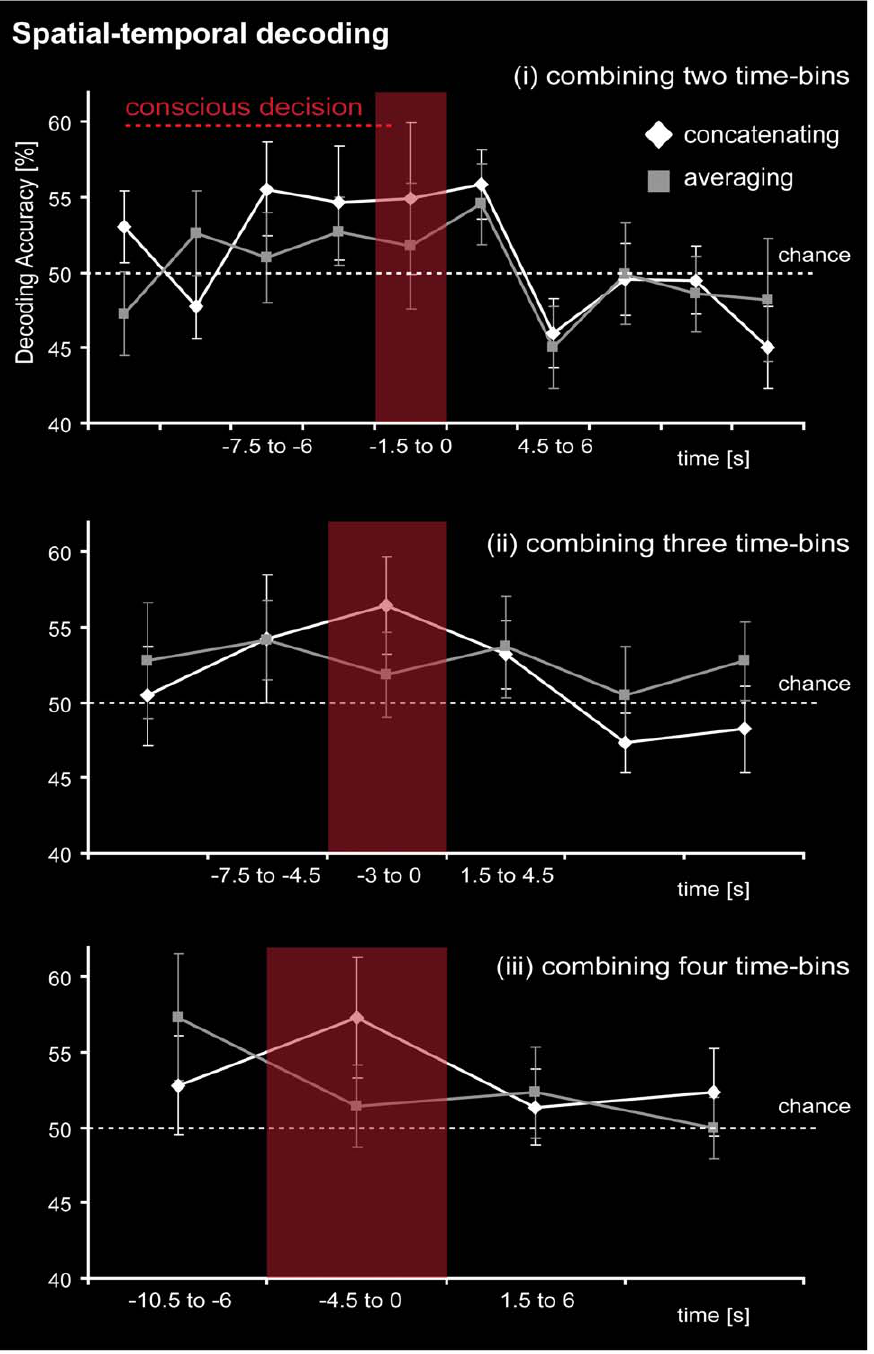
Figure 6. Temporal pattern stability. Temporal-spatial decoding analysis. The spatial activation patterns from the searchlight cluster, which was found to give best results in decoding accuracy (MNI 2 23 59 2 9), was extracted in the individual subjects’ data. The original patterns from the time- bins (1 time-bin=1.5 s) were combined by concatenating (white) and averaging (grey) the respective pattern vectors in steps of either (i) two time- bins, (ii) three time-bins, or (iii) four time-bins. The reference time-bin for vector concatenation was the time point of the decision (time 0 s). The resulting pattern vectors additionally represented temporal information for the best searchlight cluster and were used for multivariate decoding. Temporal-spatial information was found to be highest directly preceding the decision and was still present when four time bins were concatenated. Concatenating was superior to averaging by trend. doi:10.1371/journal.pone.0021612.g006 organized prefrontal functional architecture. Prefrontal cortex of a desired act, together with context-relevant information such as represents sensory input information in its most abstract form and environmental context, task-rules, motivation and potential out- guides cognitive control [42]. It maintains the abstract representation comes [29,43–45]; the motor plan for the execution of this act is